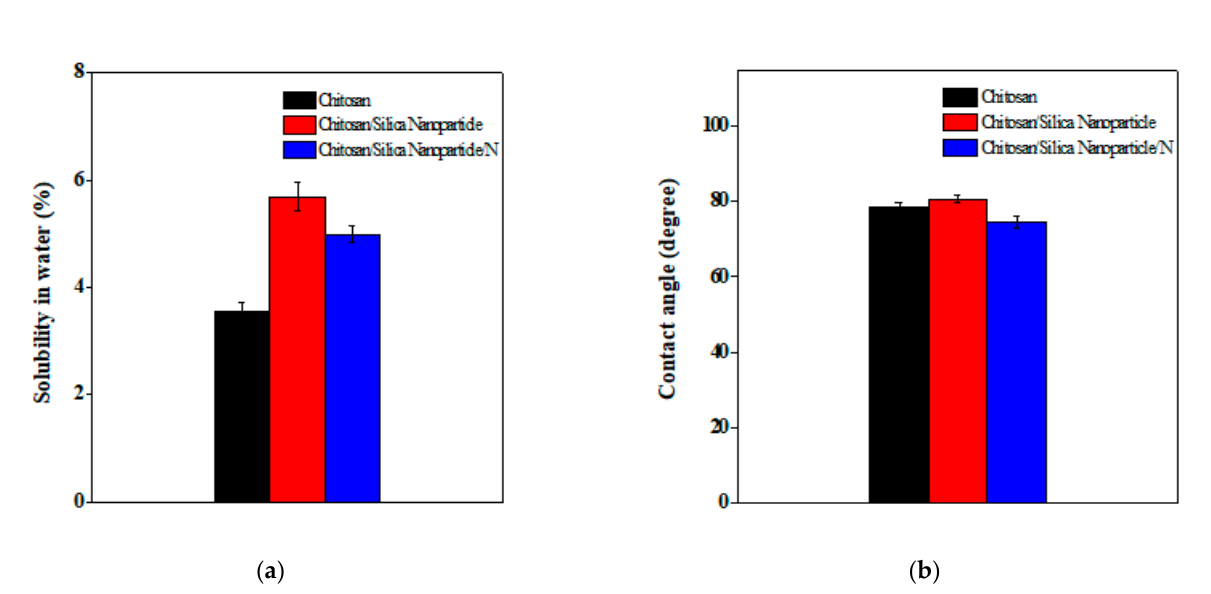
Figure 6. Solubility in water ( a ) and contact angle ( b ) of the novel films.